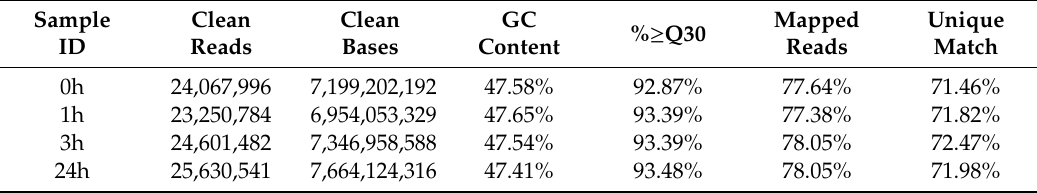
Table 1. The alignment statistics result with the reference gene for all